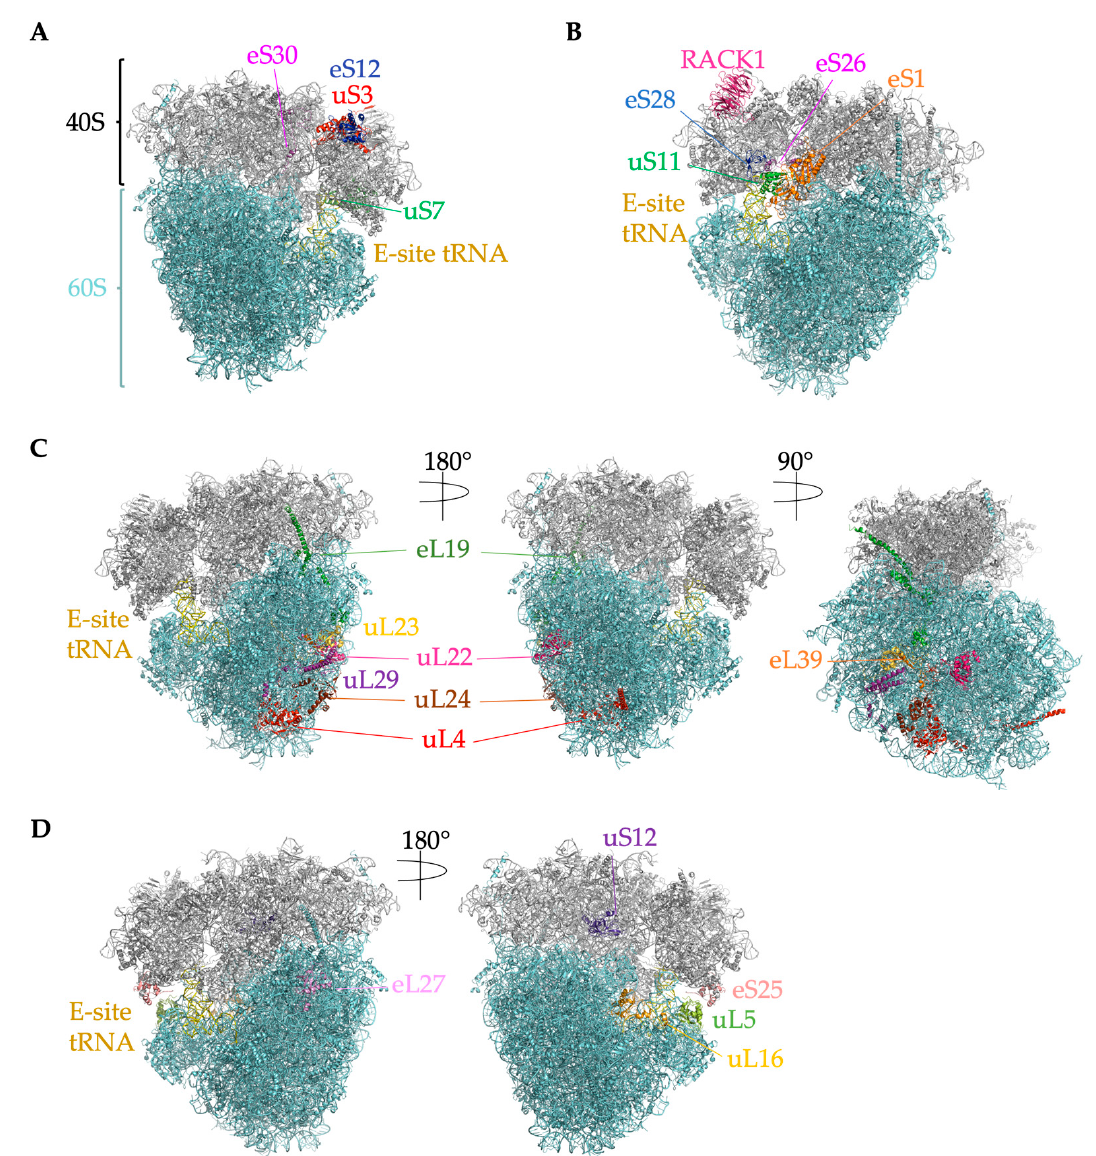
Figure 2. Locations of ribosomal proteins that potentially contribute to specialization. ( A ) The mRNA entry tunnel RPs are indicated: eS30/RPS30, eS12/RPS12, uS3/RPS3, and uS7/RPS5. The E-site of PDB 6QZP is indicated by a yellow tRNA for orientation. Both 40S (light gray) and 60S (cyan) subunits are indicated. The ribosome has the position of − y and is indicated by the E-site tRNA on the right-hand side of the image. ( B ) The mRNA exit tunnel RPs are indicated: uS11/RPS14, eS28/RPS28, eS26/RPS26, and eS1/RPS3A. The ribosome has the position of +y and is indicated by the E-site tRNA on the left-hand side of the image. Panel ( A ) is 180 degrees from ( B ). ( C ) The nascent polypeptide exit tunnel (NPET) RPs are indicated in different colors: eL19/RPL19, uL23/RPL23A, uL22/RPL22, uL29/RPL35, uL24/RPL26, uL4/RPL4, and eL39/RPL39. Both the +y and − y ribosome directions are indicated by the 180 ◦ turn, with an additional 90 ◦ turn (total 270 ◦ degrees) to better show eL39/RPL39. ( D ) The locations of RPs in tRNA binding pockets are indicated by different colors: eL27/RPL27, uS12/RPS23, eS25/RPS25, uL5/RPL11, and uL16/RPL10. The E-site is indicated as before for orientation, as well as the 40S and 60S proteins. This figure was created using PyMOL.